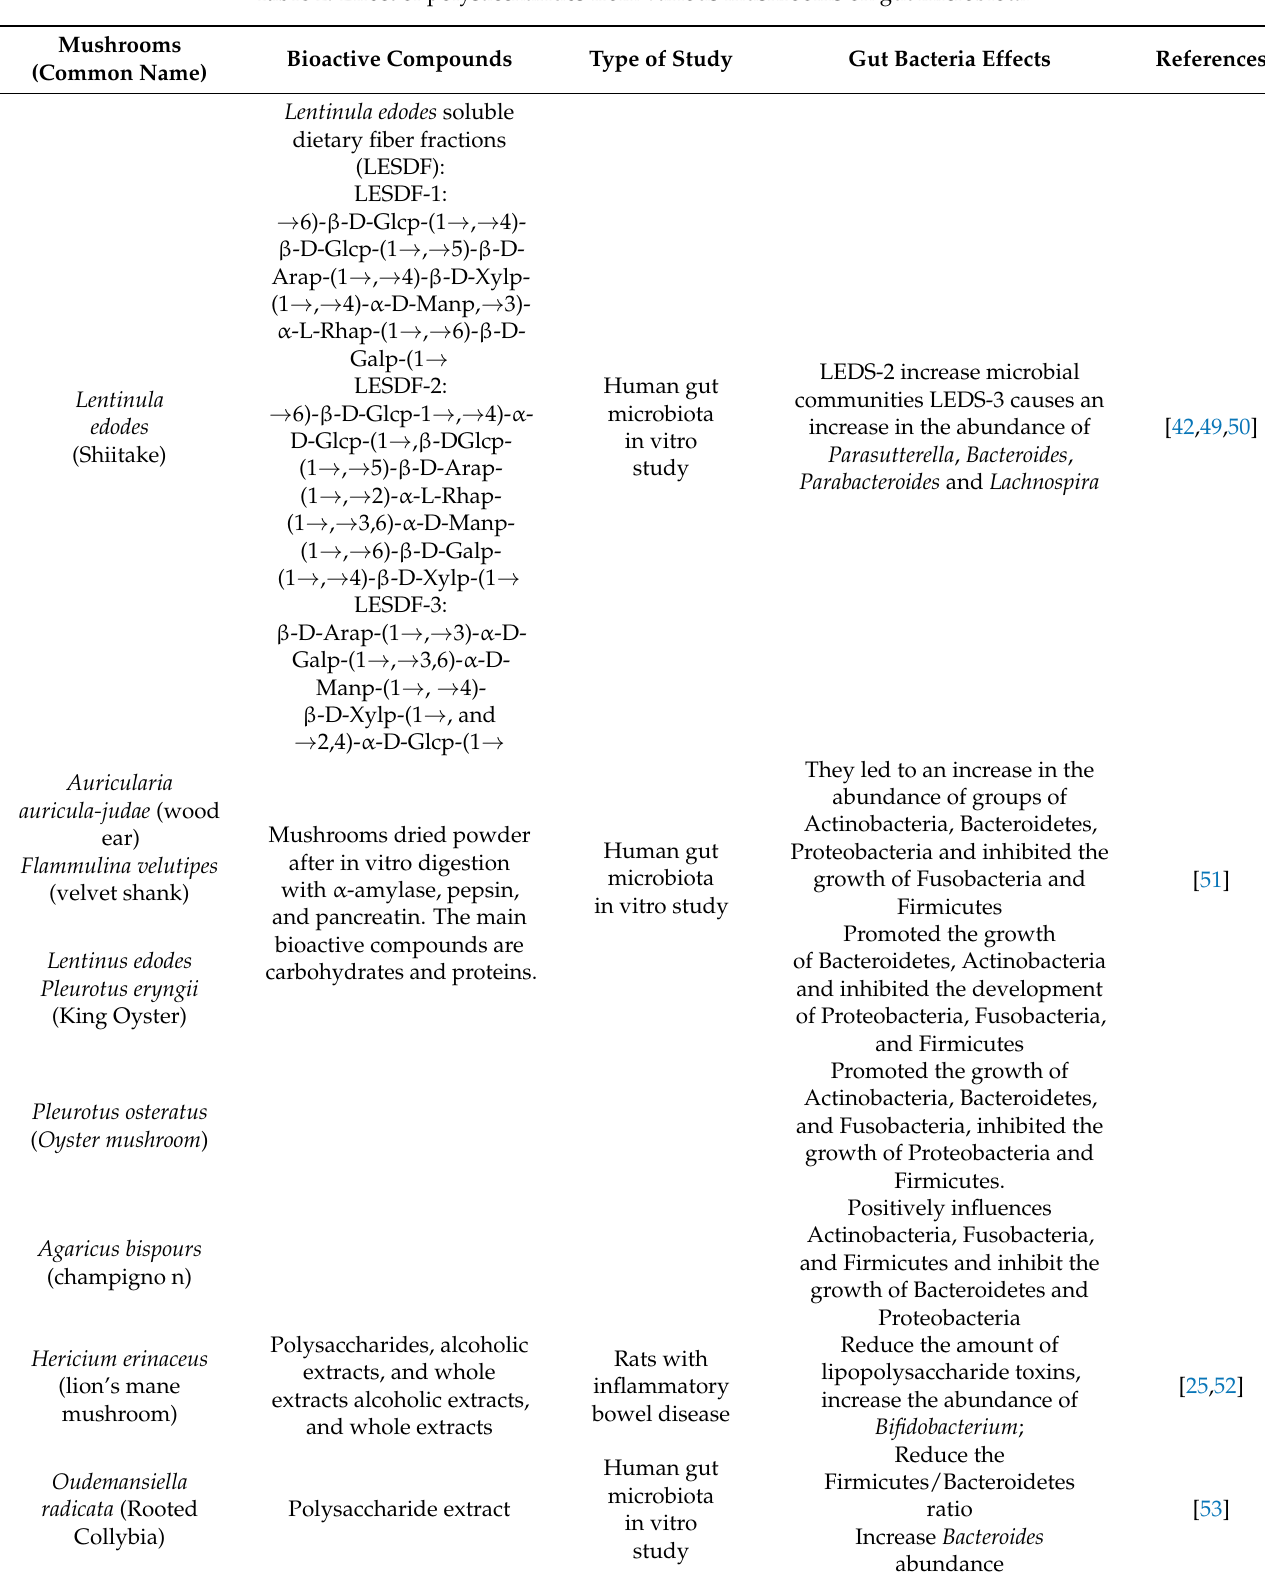
Table 2. Effect of polysaccharides from various mushrooms on gut